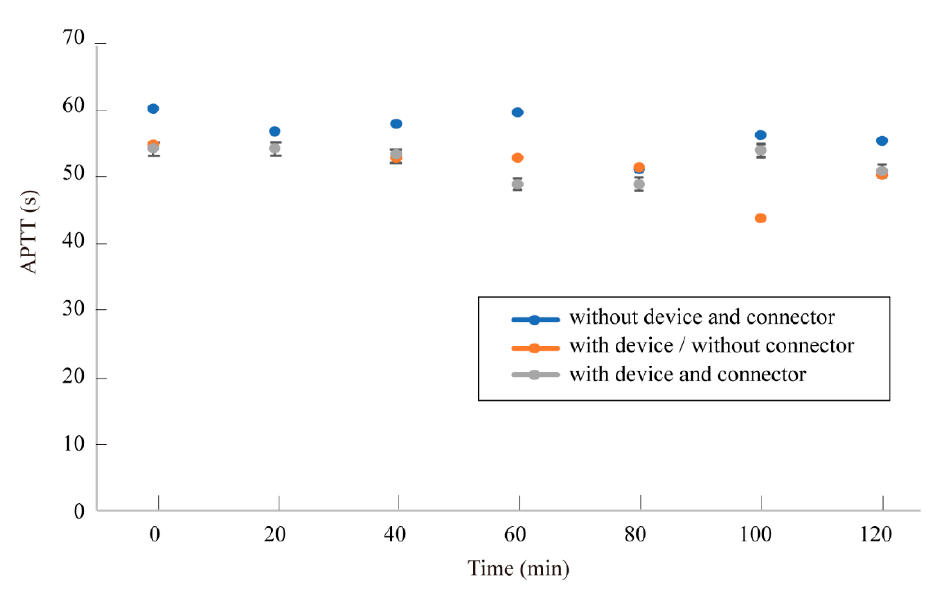
Figure 7. Progress of APTT with the device and the connector. During 120 min of experiments, no significant differences were observed.